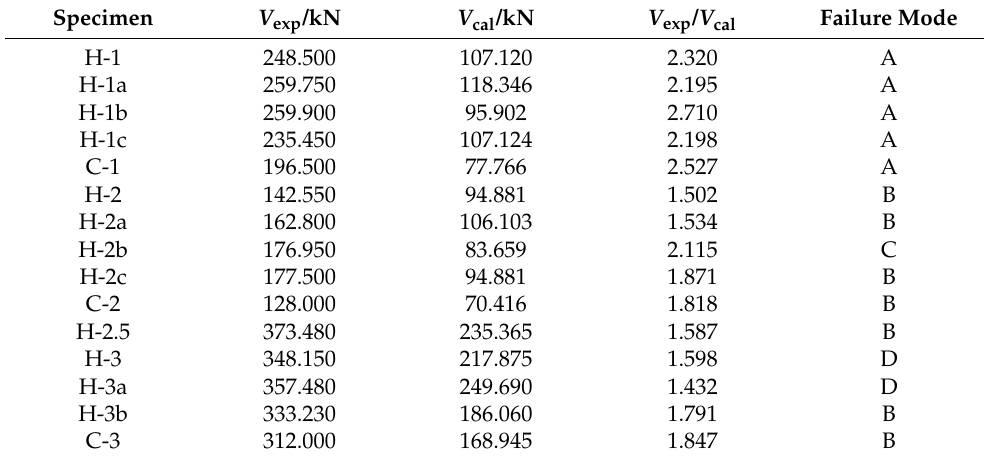
Table 9. Comparison of experimental and calculated shear strength